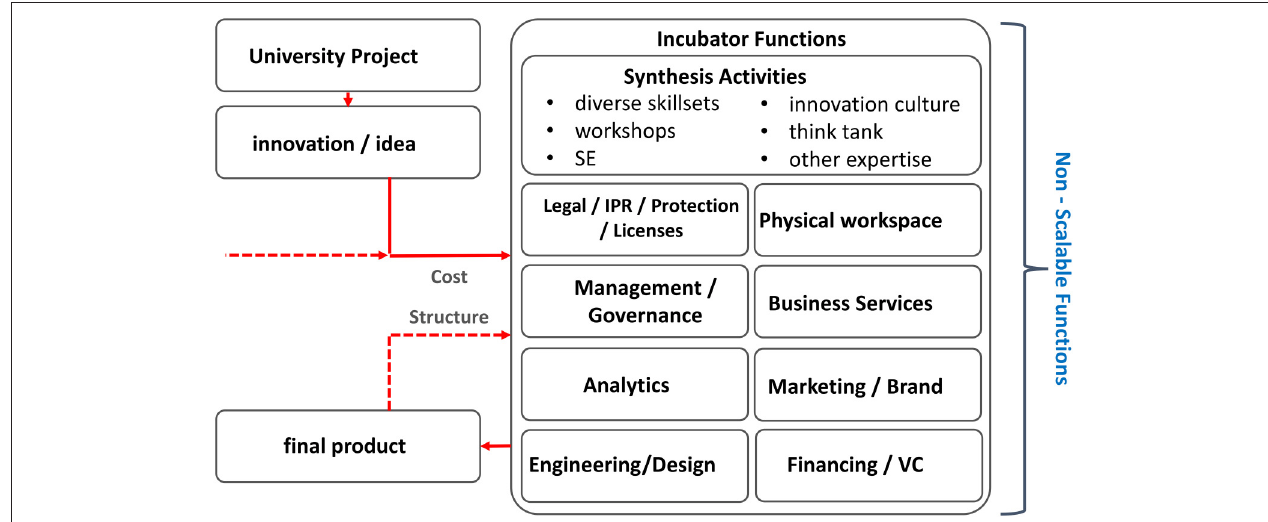
FIGURE 1 | University-based innovation incubator hub model. With core, internal incubator functions on the right, and external activities on the left. SE, system engineering; VC, Venture capital. Description of “synthesis activities” can be found in Specht (2017).